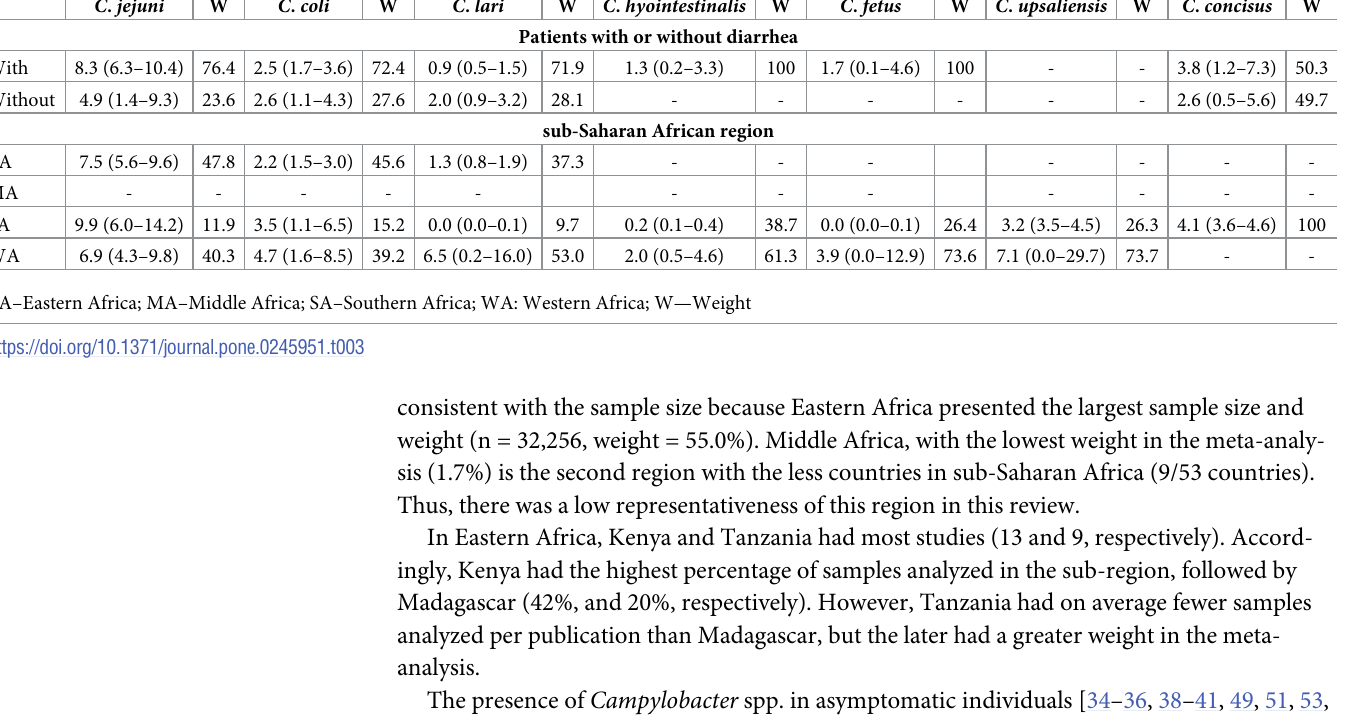
Table 3. Pooled prevalence and 95% CI of different Campylobacter species according to presence of diarrhea and sub-Saharan African region.